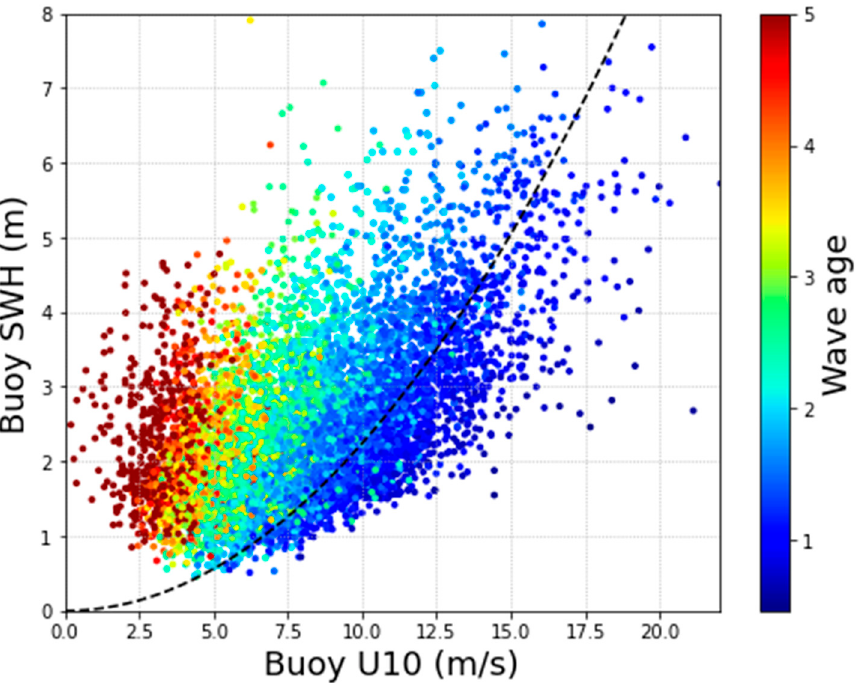
Figure 3. Scatter diagram of 10-m wind speed and significant wave height (SWH) from ASCAT-buoy co-located data set. The color denotes wave age, and dashed curve presents the wind–wave relation in fully developed sea state from Pierson–Moskowitz spectrum according to Equation (2).